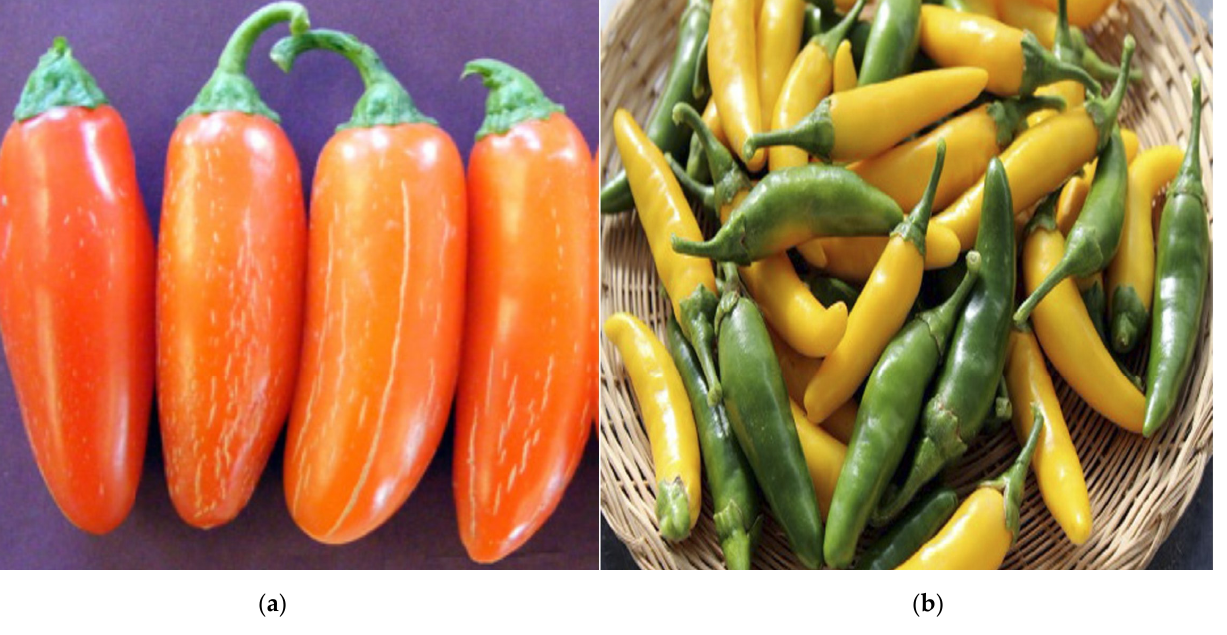
Figure 1. ‘Numex Pumpkin Spice’ ( a ) and ‘NuMex LotaLutein’ ( b ) fruits showing their characteristic orange and yellow colors, respectively. ‘NuMex Pumpkin Spice’ is a colored jalapeño, whereas ‘NuMex LotaLutein’ is a biofortified serrano type with improved lutein content. Adapted with permis-